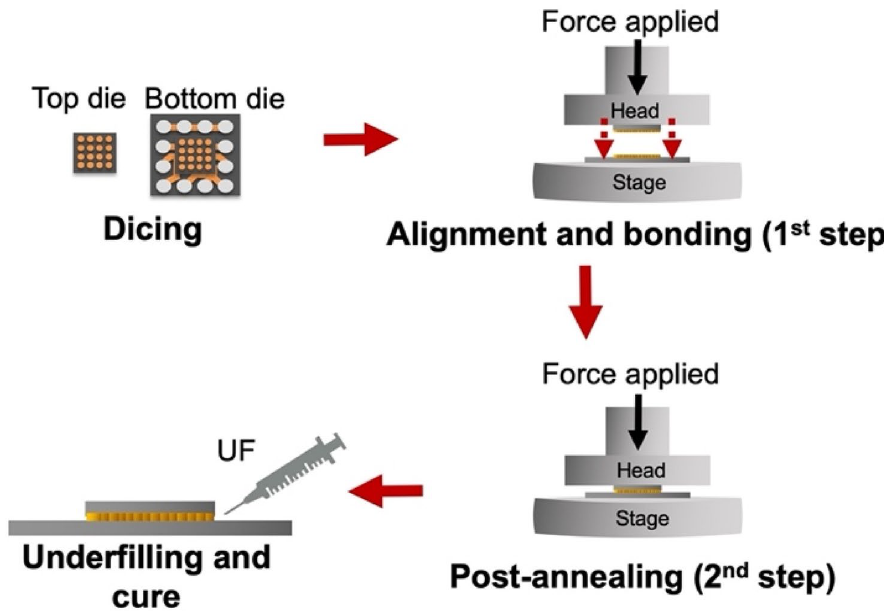
Figure 1. Fabrication flow of the two-step bonding procedure of nt-Cu microbumps.